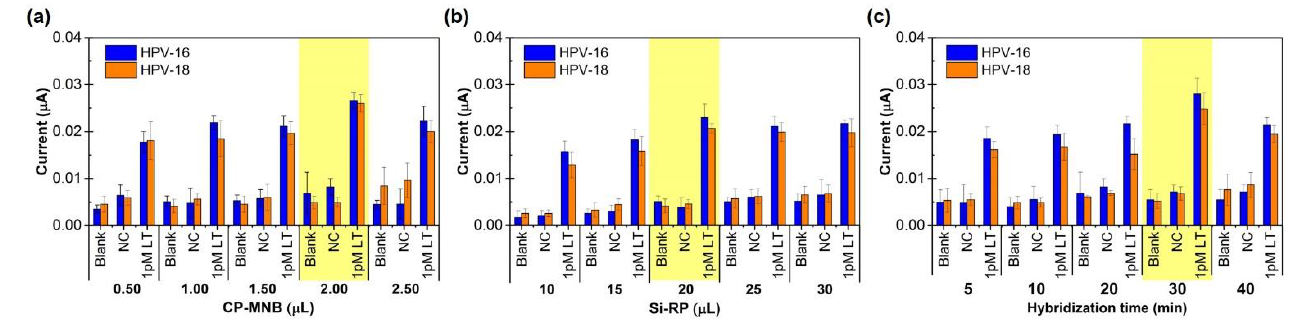
Figure 2. Optimization of the assay conditions. The effect of varying the amount of CP-MNB ( a ), Si-RP ( b ), and hybridization time ( c ) on the current responses using 1 pM LT of each HPV genotype. The conditions that provided the best signals for both HPV-16 and HPV-18 are highlighted in yellow. The best sensor performance was achieved with 2.0 µ L of CP-MNB, 20 µ L of Si-RP, and 30 min hybridization time. All current responses are presented as mean values ± standard deviation (SD), n = 5.